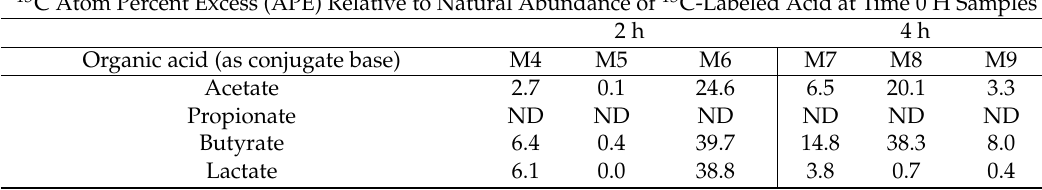
Table 3. Organic acid fermentation product 13 C atom percent excess (APE) relative to natural abundance of 13 C-labeled acid at time 0 h samples, from caecal contents of individual mice after administration of resistant starch (RS; 2 h and 4